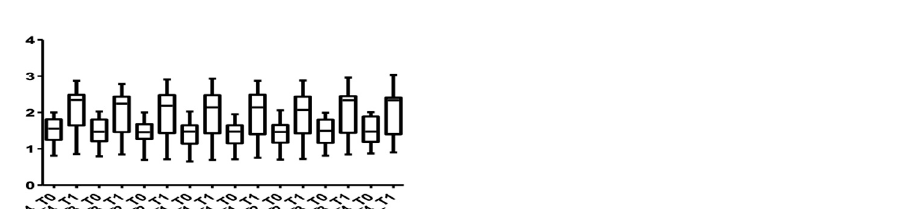
Figure 9. Distribution of CBCT values at the cervical level, upper arch, for all teeth up to the first premolars at T0 and T1.